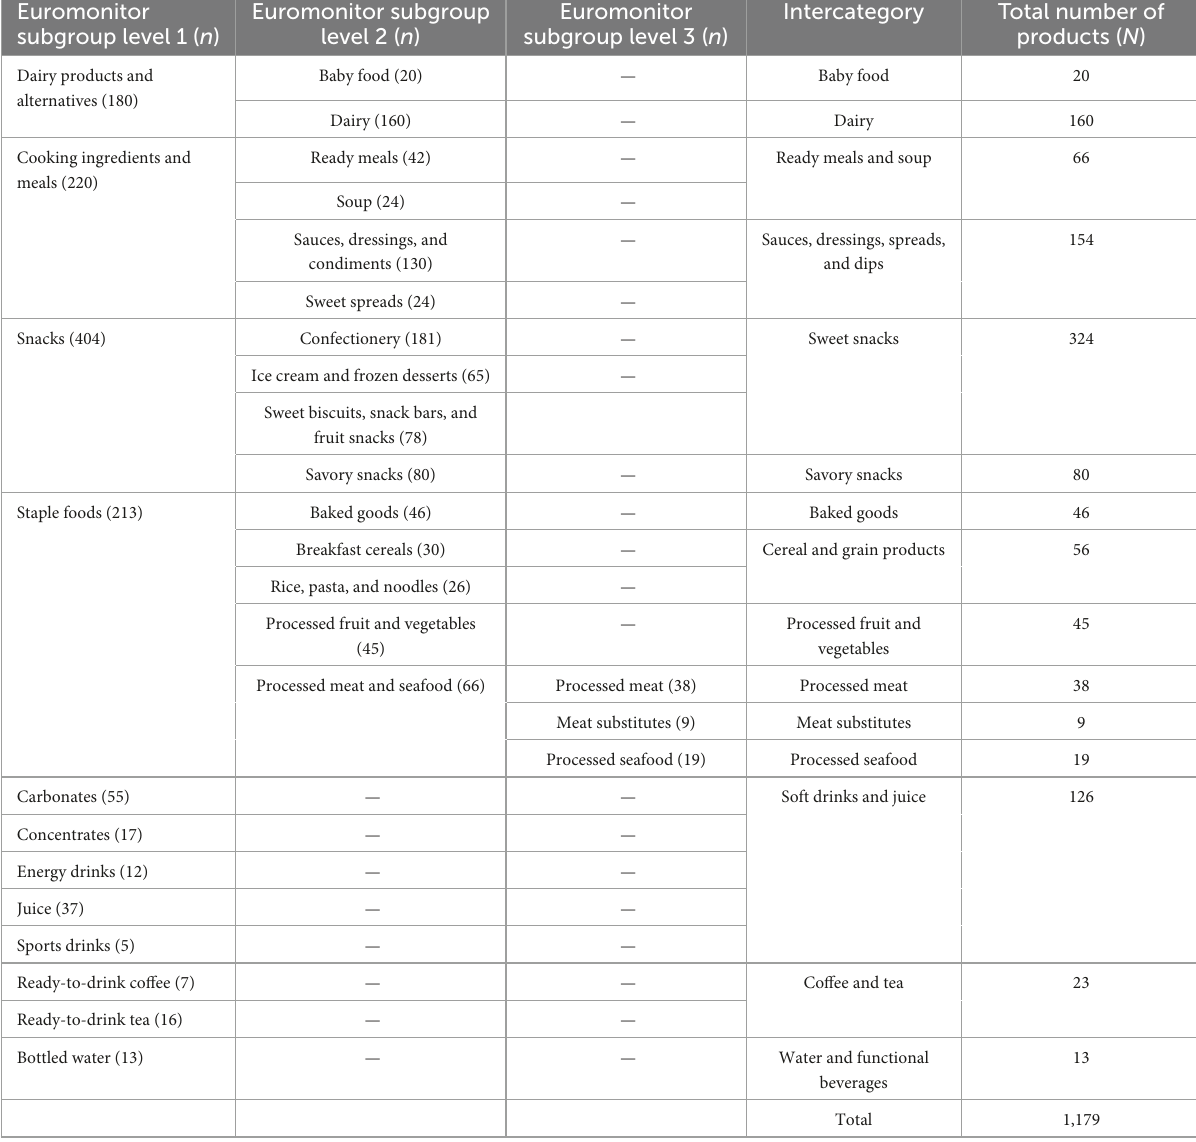
TABLE 2 The 15 intercategories generated for this work, the number of products in each intercategory (N), and the contributing Euromonitor subgroup levels (and their numbers of products = n ). Euromonitor subgroup level 1 ( n